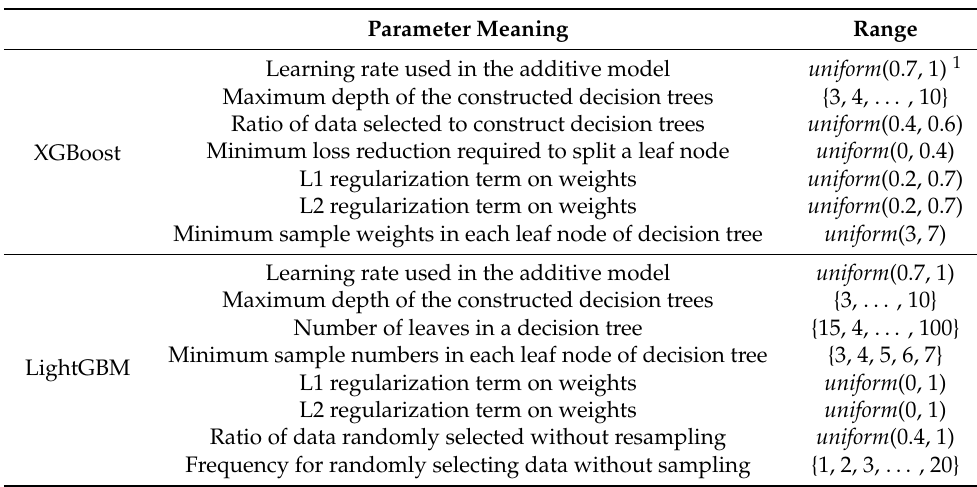
Table 3. Ranges of main tunable hyper-parameters of the tested